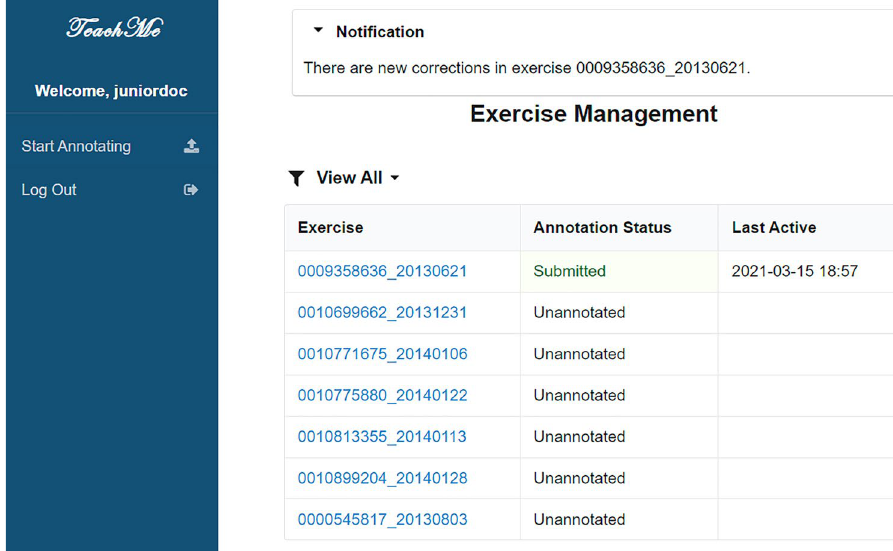
Figure 5. The exercises management interface of junior doctor users.